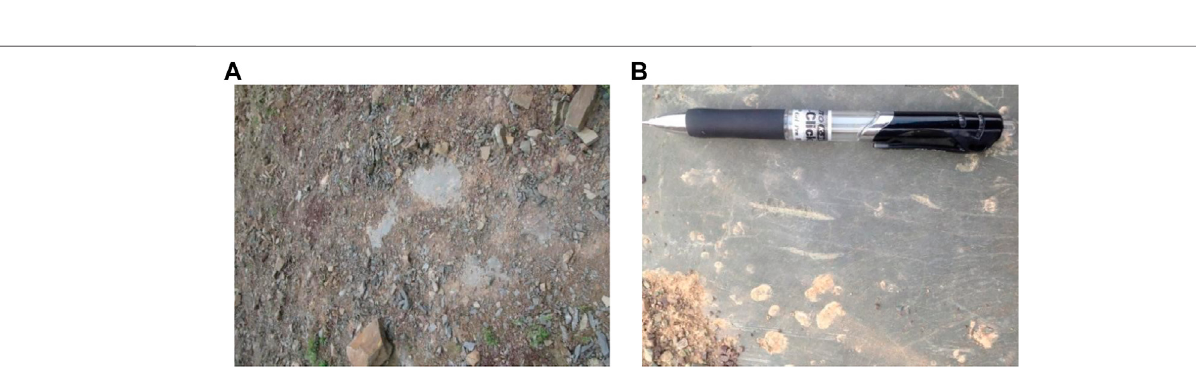
FIGURE 1 | Aerial photograph of the Shanshucao landslide (Huanghaifeng, 2016/6/9).